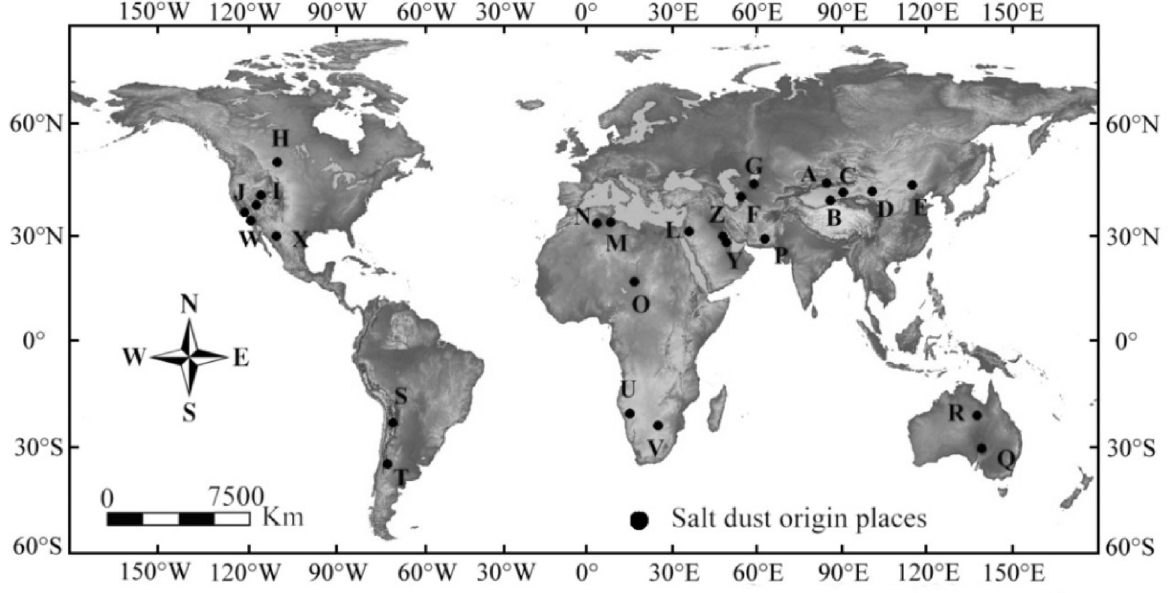
Fig 1. Distribution of saline lakes, playas and similar landforms in arid and semiarid areas susceptible to salt dust storms.